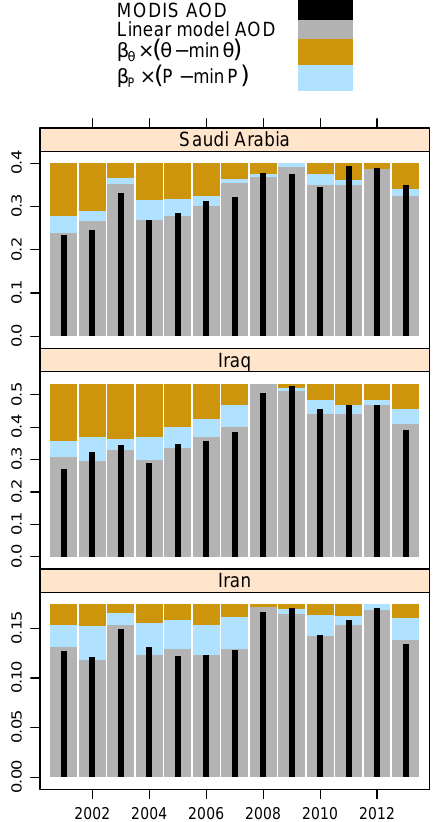
Figure 9. Comparison of MODIS observations (black) and linearly modelled AOD (grey). The brown (blue) bars represent the contri- bution of the soil moisture (precipitation) term to the interannual variability. For Saudi Arabia and Iraq, the soil moisture term is most strongly related to the AOD increase during the last decade, whereas the precipitation term adds variability. For Iran, the precip- itation term is much more relevant, indicating that aerosol transport and associated precipitation scavenging dominates the aerosol vari- ability.